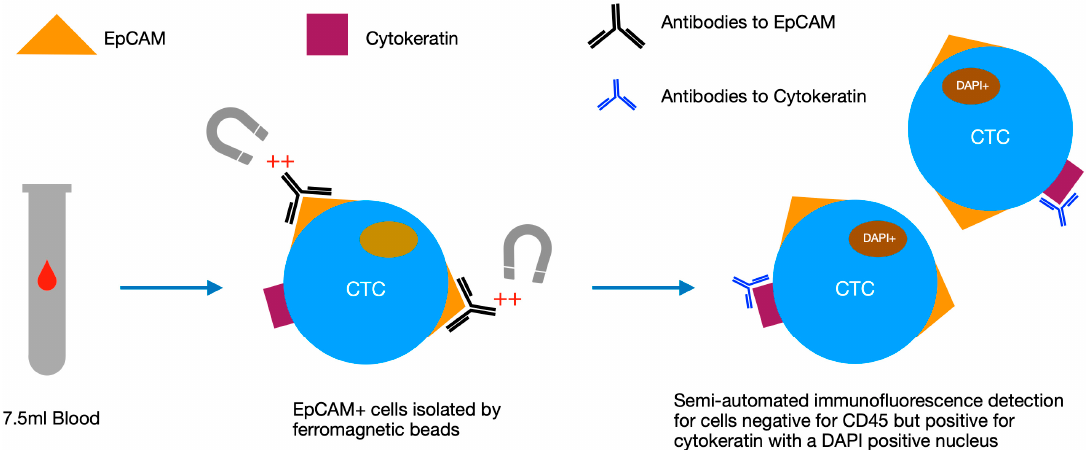
Figure 2. Diagram of the stages of analysis in the CellSearch ® system, which uses a semi-automated process to select for epithelial cells with specific antibody signatures and morphology. CTC: circulating tumour cell, EpCAM: epithelial cell adhesion, DAPI: 4 ′ 6-diamidino-2-phenylindole.